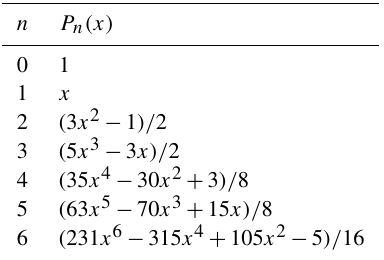
Table A1. Legendre